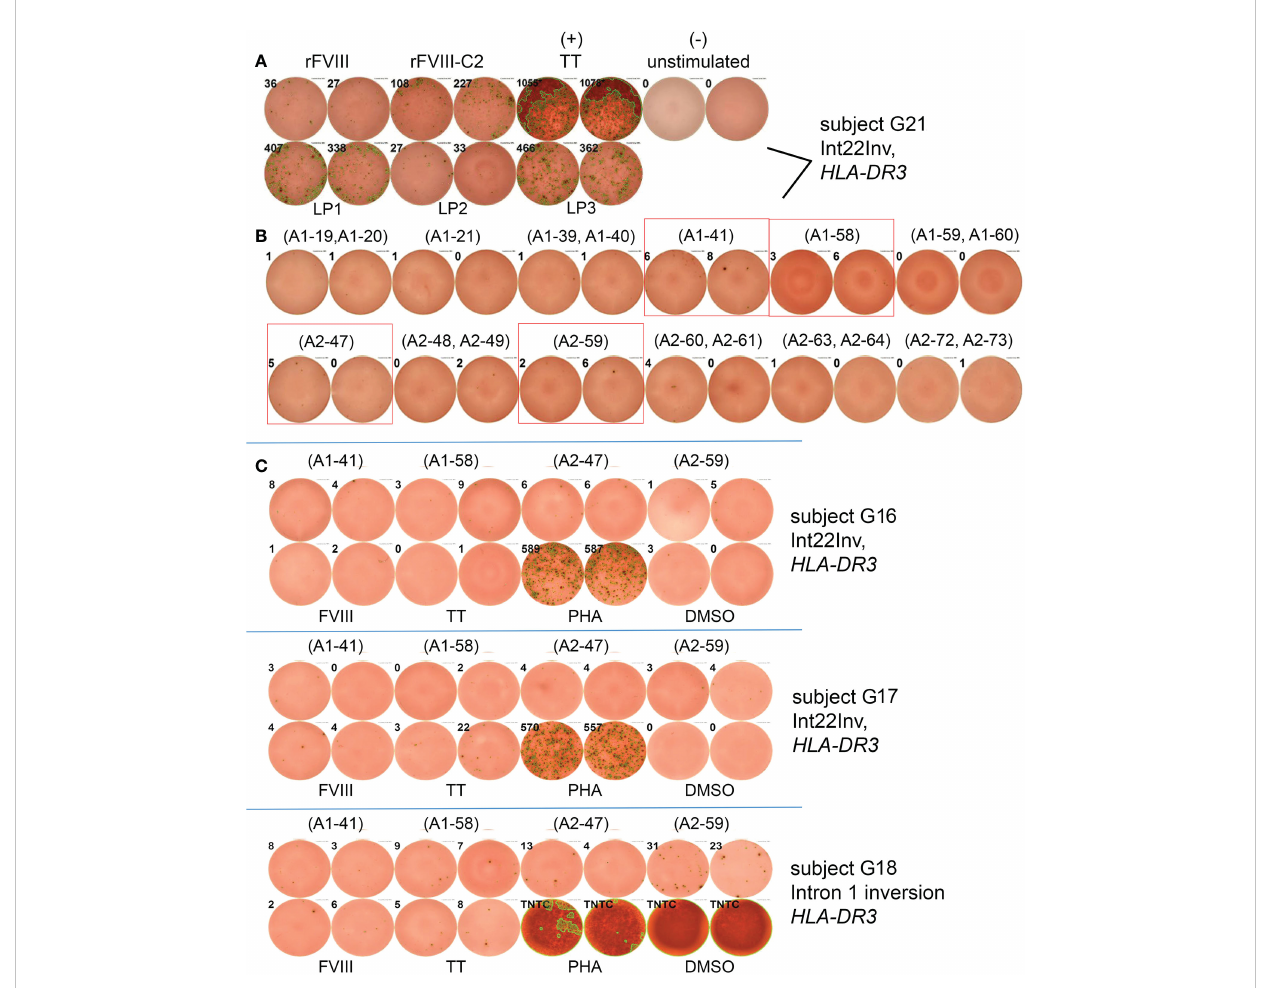
FIGURE 4 Epitope mapping of HLA-DRB1*0301-restricted responses to FVIII A1 and A2 domains by ELISPOT assays. (A) PBMCs from Int22Inv subject G21 responded to rFVIII and rFVIII-C2 domain protein, tetanus/diptheria toxin, and FVIII large peptide pools LP1, LP2 and LP3. Peptide pools LP1-LP3 consist of overlapping 15-mer peptides spanning the FVIII A1 and the A2 domains (Table S3). and LP2 (B) PBMCs from the same subject also responded to individual 15-mer FVIII peptides A1-41, A1-58, A2-47 and A2-59. Results for the remaining 6 peptides or peptide pools were negative and are not pictured. (C) PBMCs from an additional three Int22Inv subjects with an HLA-DR3 allele (G16, G17 and G18) showed responses above background for one or more of the 4 FVIII A1 or A2 domain peptides. The response of the fi nal subject to peptide FVIII-A2-59 (FVIII 605-619) was the most